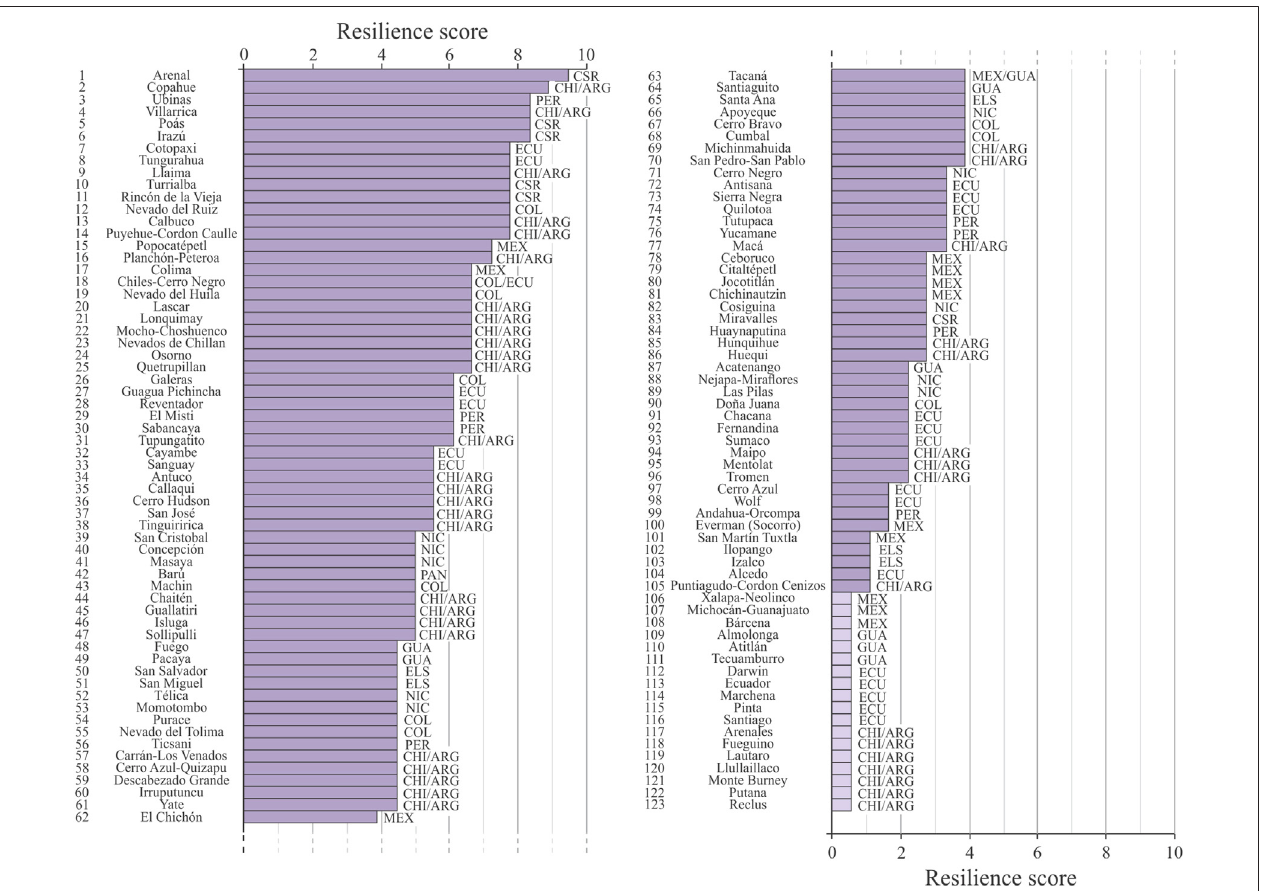
FIGURE 7 | Latin America volcanic systems with recorded activity in the past 1,000 years assessed based on their resilience score. CHI/ARG: Chile/Argentina; COL: Colombia; CSR: Costa Rica; ECU: Ecuador; ELS: El Salvador; GUA: Guatemala; MEX: México; NIC: Nicaragua; PER: Peru.